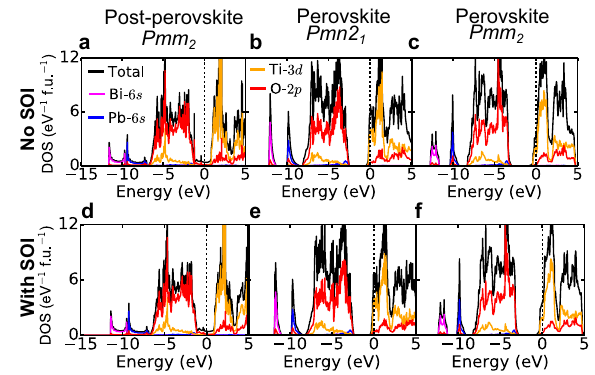
Fig. 2 Densities of states (DOS) of BPTO of the three polar structures. The upper and lower panels show the DOS calculated by DFT without spin- orbit interactions (SOI) and DFT with SOI, respectively. a , d The post- perovskite structure with Pmm 2 symmetry; b , e The perovskite structure with Pmn 2 1 symmetry; c , f The perovskite structure with Pmm 2 symmetry. The black curve is the total DOS. The magenta, blue, orange, and red curves are Bi-6 s , Pb-6 s , Ti-3 d , and O-2 p projected DOS, respectively. The dashed line is the Fermi level.